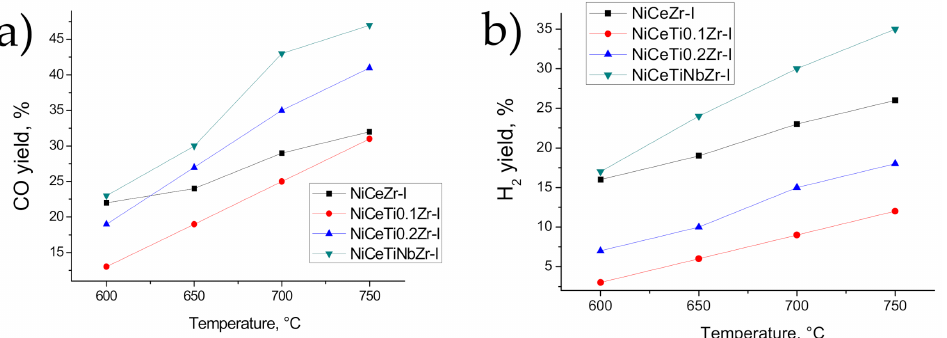
Figure 7. The dependences of ( a ) CO yield and ( b ) H 2 yield on temperature for impregnated samples.